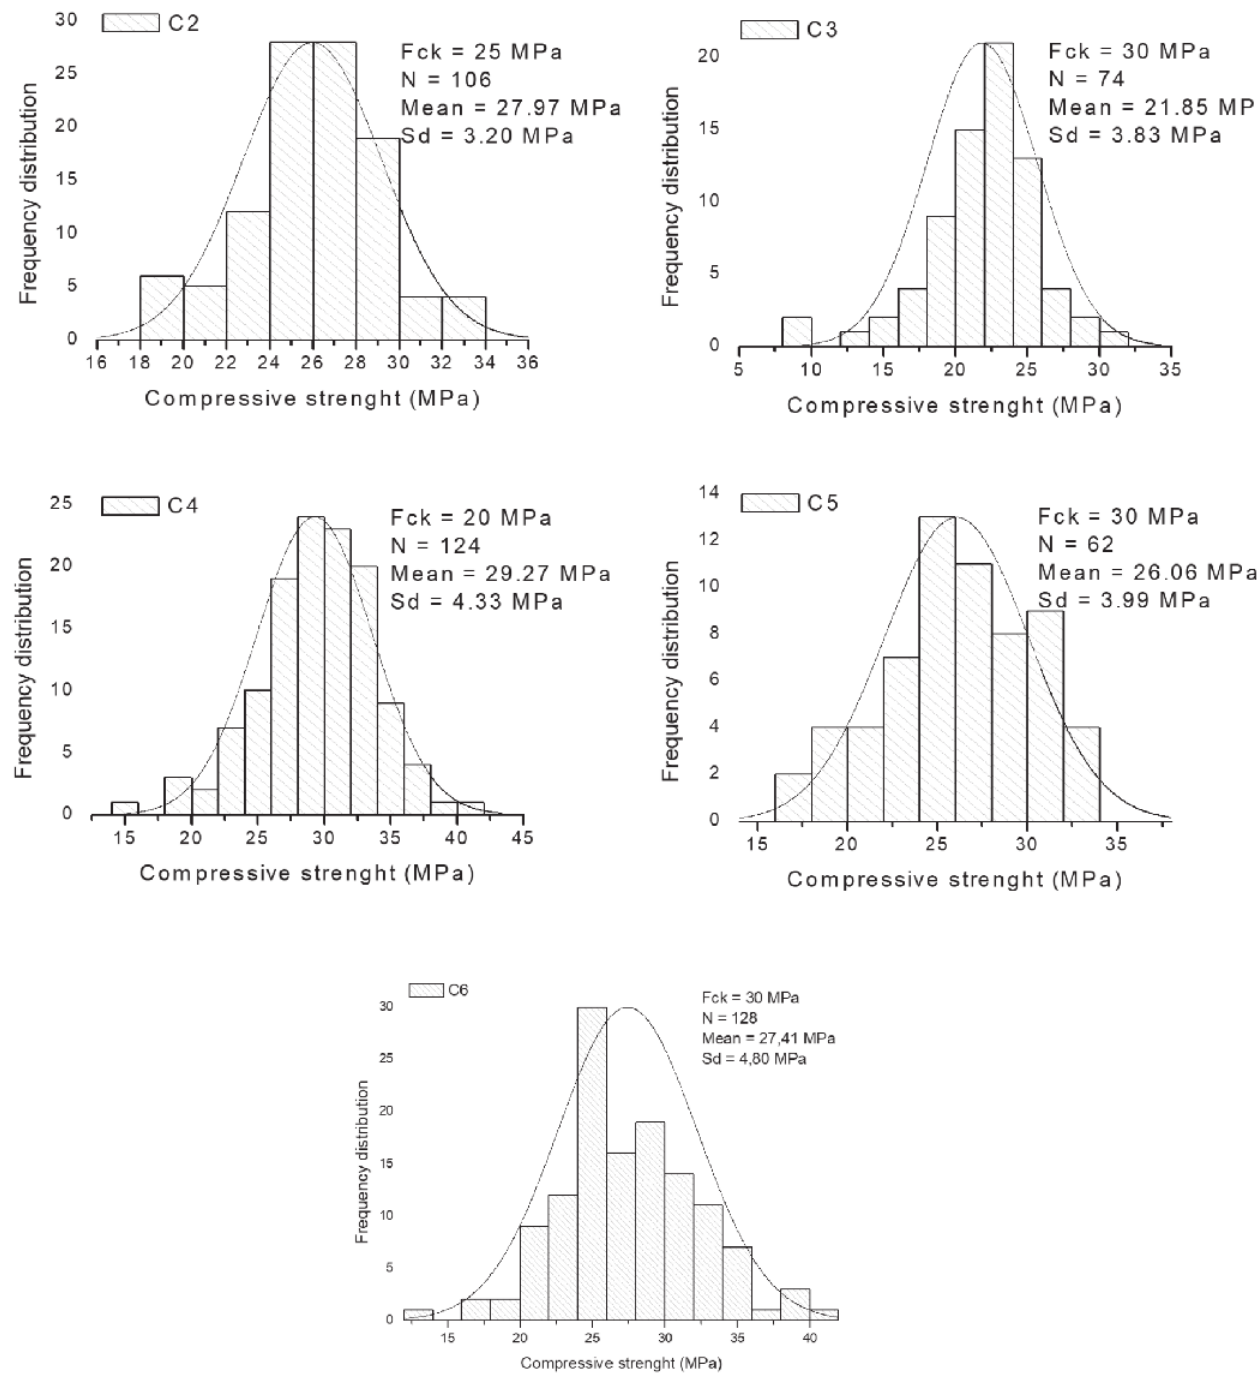
Normal distribution of the compressive strenght values of the concretes